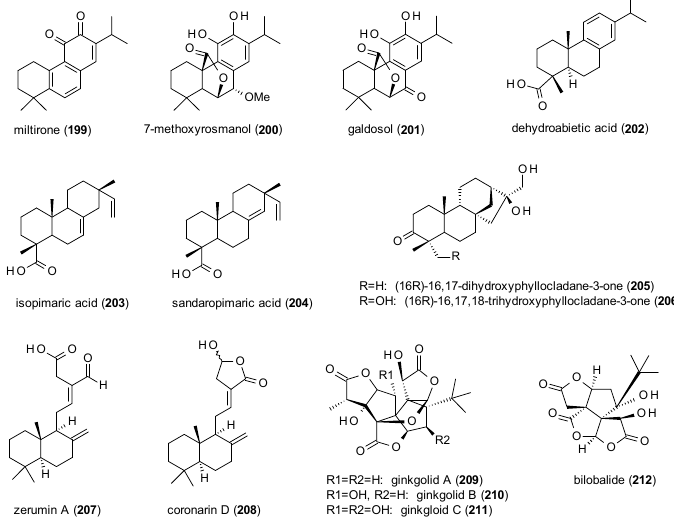
Figure 13. Chemical structures of diterpenes with reported GABA(A)-receptor modulating activity. 7-methoxyrosmanol ( 200 ) and galdosol ( 201 ), two compounds isolated from Salvia officinalis ,